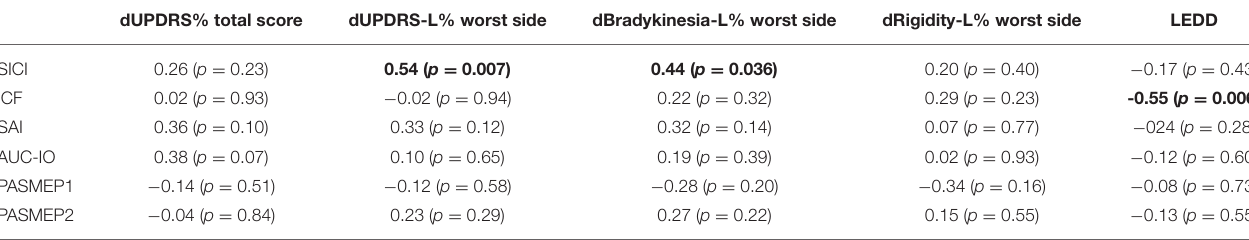
Presented are values of Spearman R with probability of null hypothesis in brackets. Significant results are marked in bold. UPDRS, Unified Parkinson’s Disease Rating Scale [Fahn and Elton, (11)]; d%, relative difference; L, lateralized; SICI, short-latency intracortical inhibition; ICF, intracortical facilitation; SAI, short-latency afferent inhibition; AUC-IO, area under the